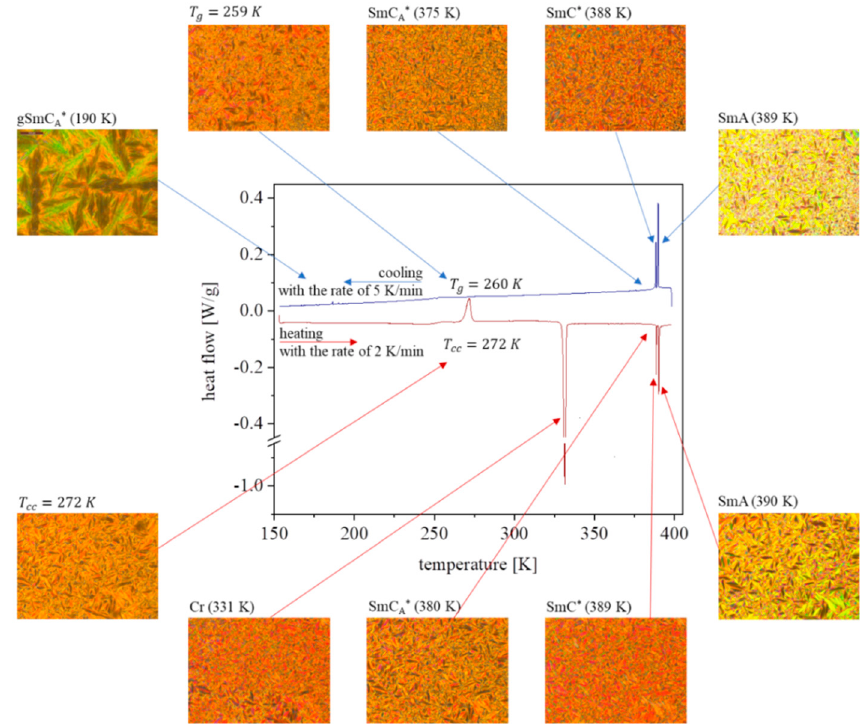
Figure 2. DSC thermograms recorded during heating with the rate of 2 K/min (red line) and cooling with the rate of 5 K/min (blue line) cycle. Inset images correspond to the textures of thermodynamic phases of 3F7HPhH observed under polarizing microscope.